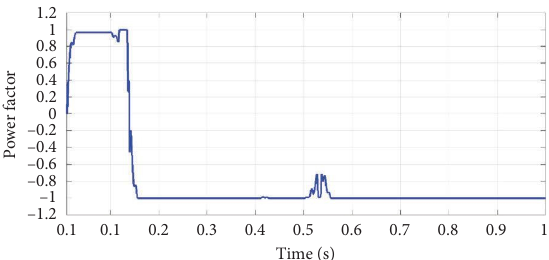
Figure 27: Modulation coefcients of